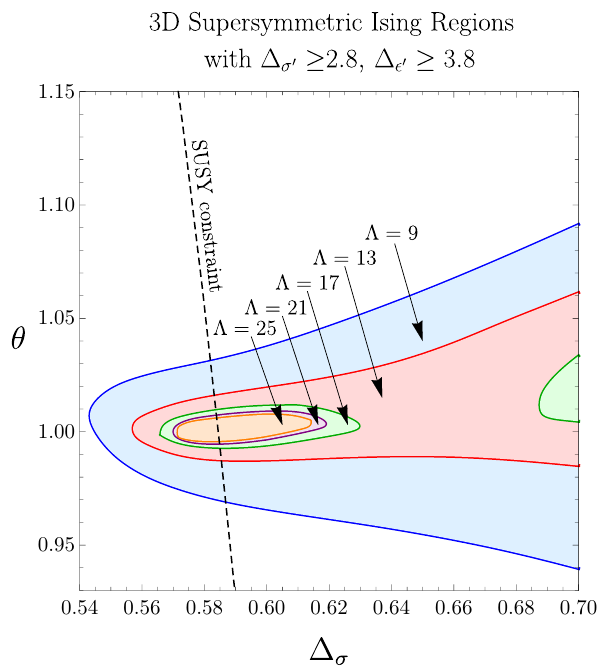
Figure 5 . A plot of the non-excluded regions with gap assumptions of (cid:1) (cid:27) 0 = (cid:1) (cid:15) 0 (cid:0) 1 (cid:21) 2 : 8 along the supersymmetric line (cid:1) (cid:15) = (cid:1) (cid:27) + 1. The shaded regions are obtained at derivative